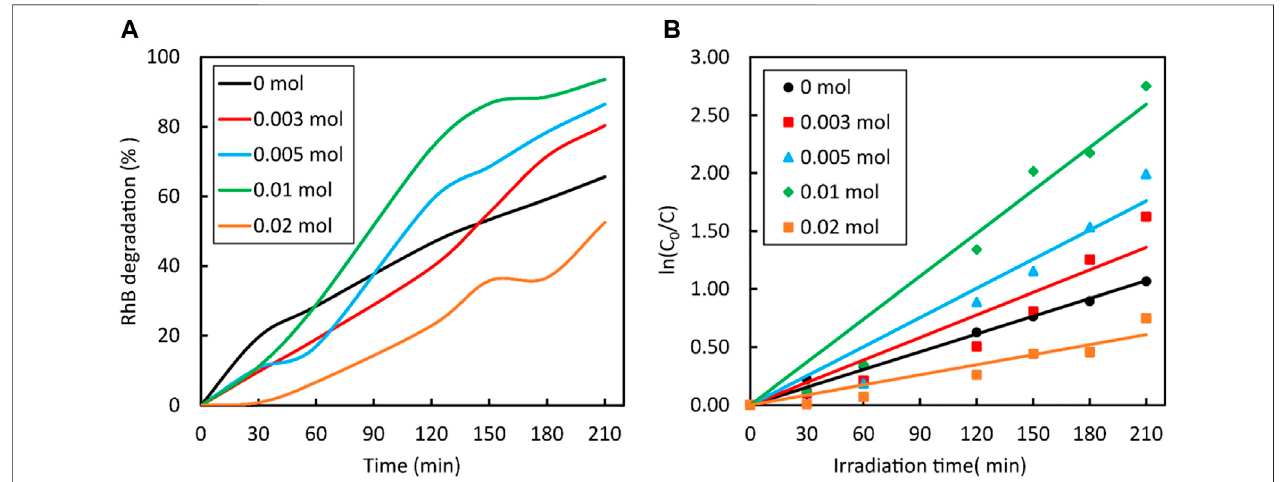
FIGURE 11 | Degradation rate of RhB dye by on the (A) and the kinetic curves for the degradation of Rh B dye by ZnS on the (B) , both prepared using different amounts of NaBH